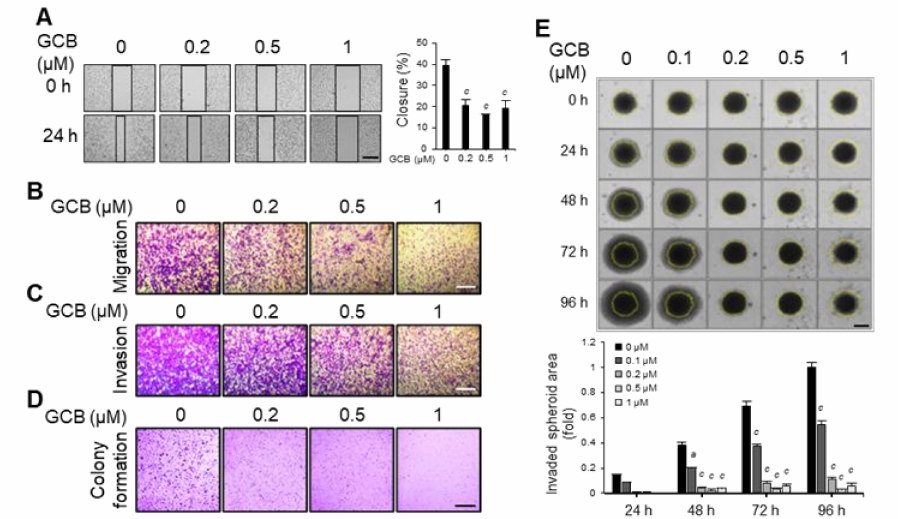
Figure 2. GCB could inhibit cancer cell migration and invasion. ( A ) Huh7 cells were incubated with GCB (0, 0.2, 0.5, and 1 µ M). Microscopic images were taken at 24 h (scale bars, 0.5 mm). The wound closure values were quantified by measuring the percentage of wound closure in comparison with the 0 h point for each sample; the relative wound closure is shown as a bar graph. Data were analyzed by one-way ANOVA; c p < 0.001 relative to the untreated control. ( B ) Huh7 cells were seeded in the upper chambers of transwell plates and treated with GCB (0, 0.2, 0.5, and 1 µ M) for 18 h. Images of the cells that had migrated to the other side of the membrane were taken (scale bars, 0.5 mm). ( C ) Huh7 cells were seeded with the indicated concentration of GCB in the upper chambers coated with Matrigel. After incubation for 18 h, images of the invaded cells were taken (scale bars, 0.5 mm). ( D ) Huh7 cells were incubated with different concentrations of GCB (0, 0.2, 0.5, and 1 µ M). The colonies were stained with 0.5% crystal violet, and the images were then taken (scale bars, 1 cm). ( E ) Three-dimensional spheroidal Huh7 cells were incubated with GCB (0, 0.1, 0.2, 0.5, and 1 µ M) for 96 h. Microscopic images were captured using a JuLI Stage Real-Time Cell History Recorder at the indicated time points (scale bars, 0.4 mm). The yellow line indicates the outline of the spheroid at 0 h. The invaded spheroid area (fold) indicates the invaded area of a spheroid at each time in comparison with the size of the spheroid at 0 h. The invaded area was measured using ImageJ. Data were analyzed by one-way ANOVA; a p < 0.05 and c p < 0.001 relative to the GCB-untreated